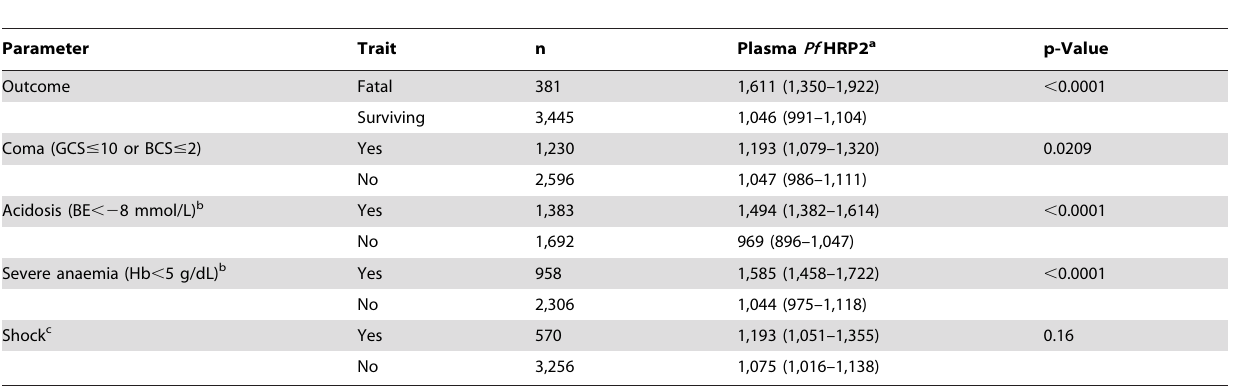
(Figure 1, bottom). In the log Pf HRP2 stratum of 3 to 3.5 (1,000 to 3,162 ng/mL) and above, the absolute risk of death due to malaria exceeded 8% with a probability of ‘‘true’’ severe malaria . 95% and a probability that a death was caused by severe malaria . 85% Table 2. Plasma Pf HRP2 according to clinical and laboratory features of severe malaria.